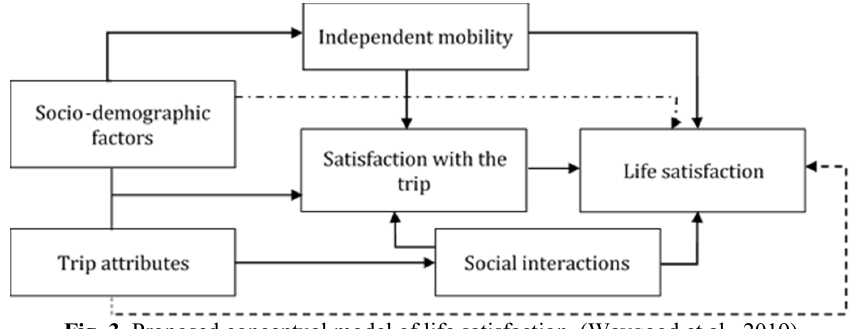
Fig. 3. Proposed conceptual model of life satisfaction. (Waygood et al.,